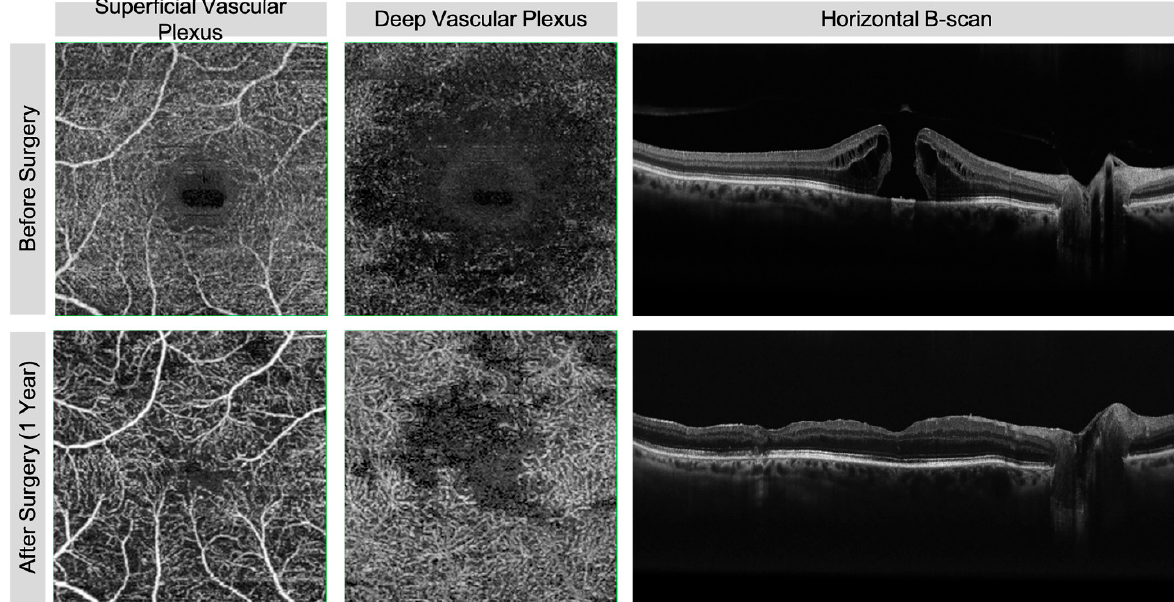
Figure 1. Spectral-domain structural optical coherence tomography (SD-OCT) horizontal B-scan and OCT-A before and 1 year after surgery for FTMH in eye with good visual acuity restoration. In OCT-A, the retinal vascular differences between baseline and after surgery are correspondent both in the superficial and deep vascular plexus. In B-scan at the baseline, the stromal interruption belongs to all retinal layers in the foveal region. Layer continuity is again observable 1 year after surgery including external limiting membrane (ELM) and partially the ellipsoid zone (EZ).